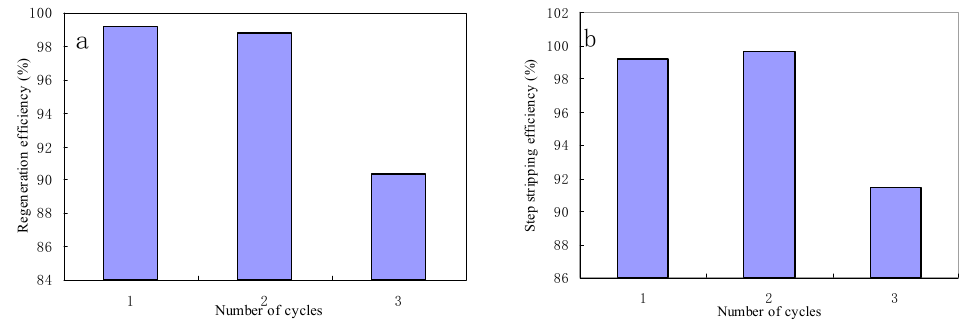
Figure 7. Evolution of regeneration efficiency ( a ) and the step-stripping efficiency ( b ) after each regeneration cycle (Fe 3 O 4 /rGO dosage = 20 mg, temperature = 25 °C, Hg ions concentration = 100 μ g/L, pH = 7).